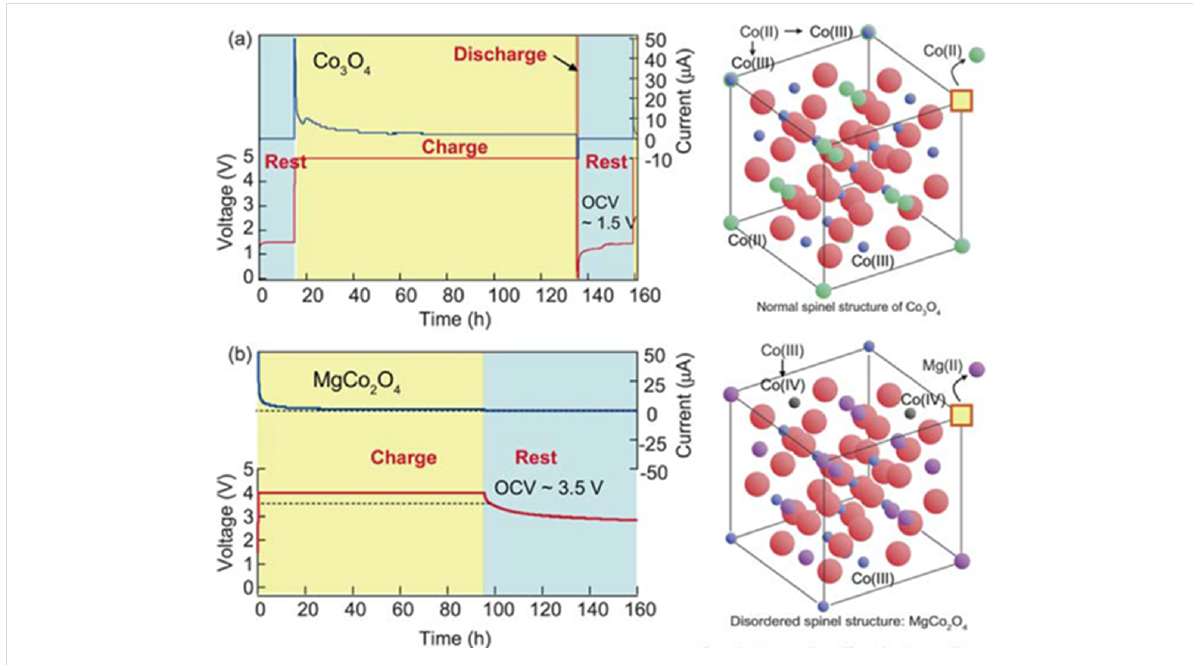
Figure 8: The OCV values of the test cells after constant voltage charge: positive electrode, (a) ordered Co 3 O 4 and (b) disordered MgCo 2 O 4 ; nega- tive electrode, Mg; electrolyte, Mg(ClO 4 ) 2 in acetonitrile. Reproduced with permission from [66]. Copyright 2011 The Royal Society of